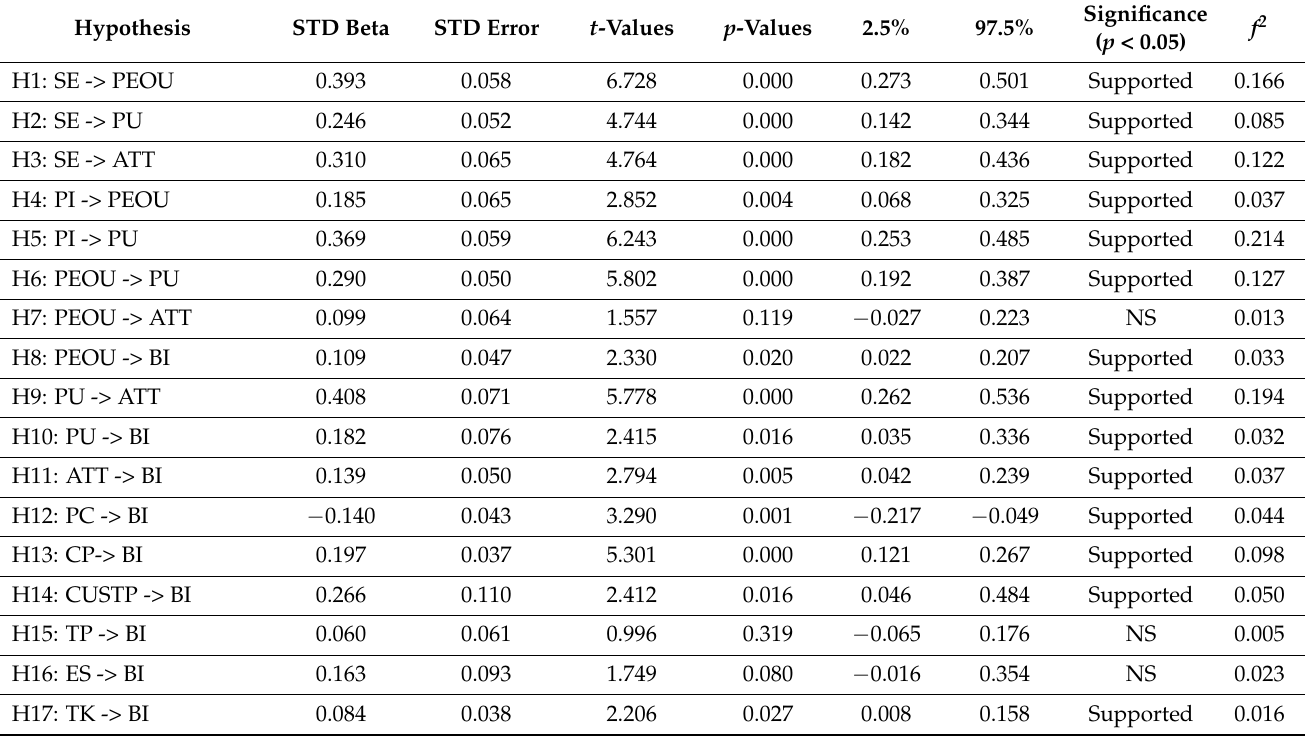
Table 5. Structural model and hypothesis testing result.